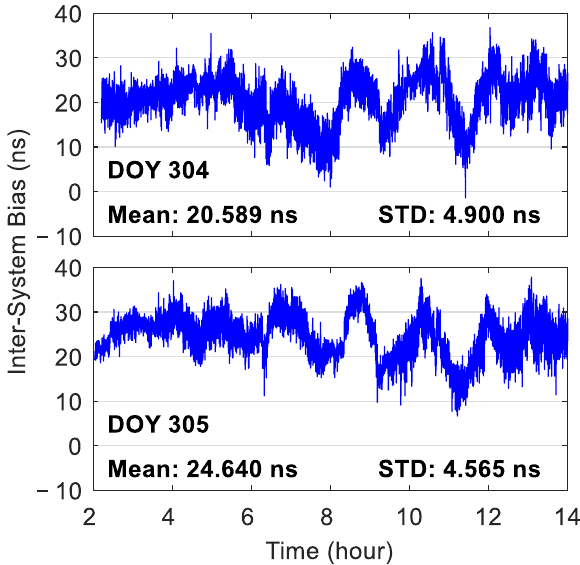
Figure 13. Epochwise ISB estimates between GLONASS and GPS derived from low-cost u-blox M8T receiver at an elevation mask angle of 10° on DOY 304 and 305 of 2021.